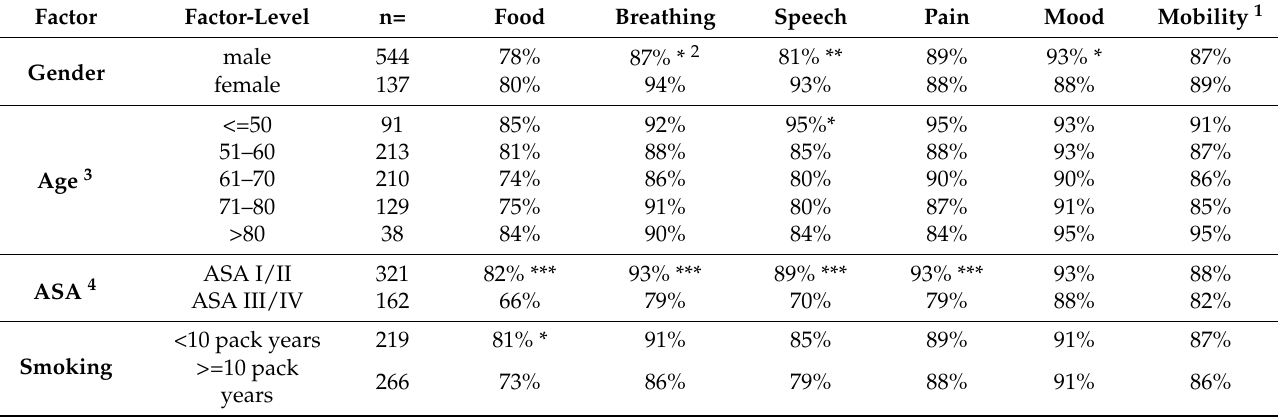
Table 2. Relative counts (percent) of 681 patients with incident head and neck cancer with normal or near-normal outcome in HNC functional integrity scales (integrity score 3 and 4) stratified by patients- and disease-related